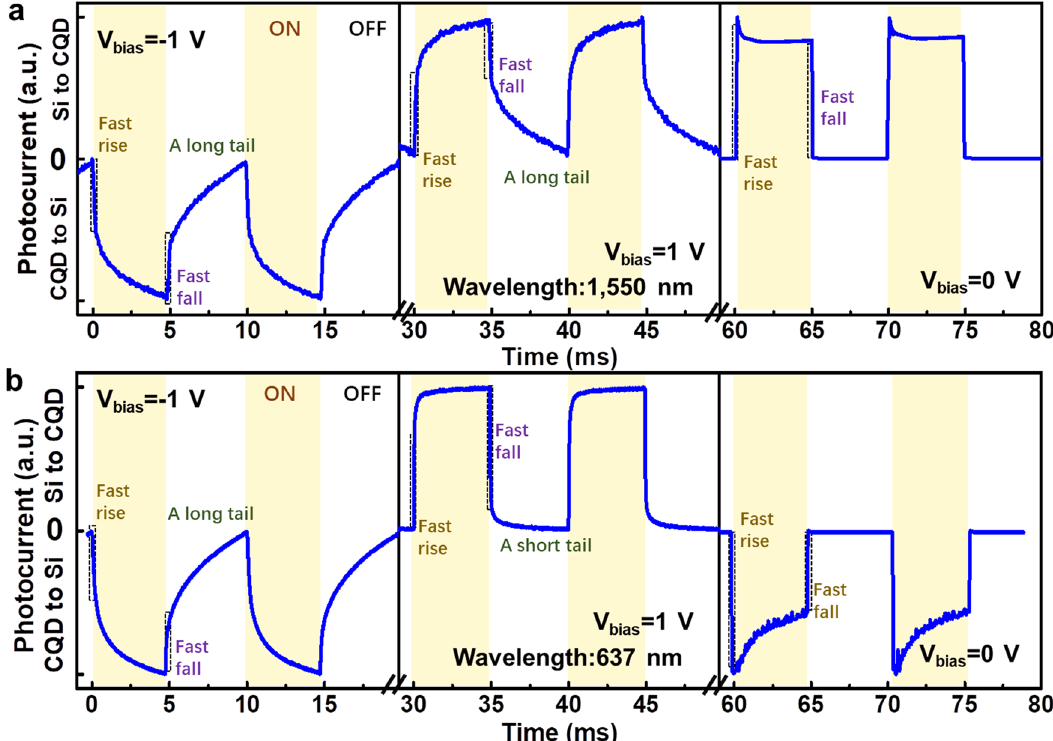
Fig. 5 Response time of the PVTRI. Response time of the PVTRI under illumination of a 1550 nm and b 637 nm,